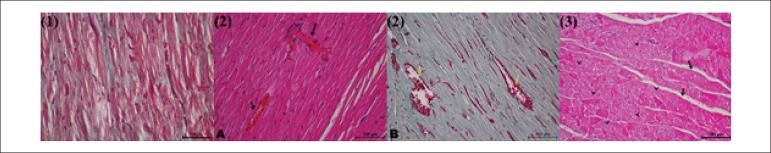
(1) Normal histological view of cardiac myofibrils in IPreC group.
(Longitudinal section, Masson Trichrome stain, Magnification: 40X).
(2) Congestion in IPreC+ MCAo (A) and STZ+ IPreC+ MCAo (B) groups.
Overview of myofibril is nearly normal appearance. (Longitudinal
section, A. H-E stain, B. Masson Trichrome stain, Magnification:
20X). (3) Eosinophilic stained areas show necrotic myofibrils that
are lack of nuclei (arrow-heads) in STZ group. Arrows indicate that
spaces between cardiac myofibrils. These spaces indicate necrotic
area, and probably interstitial edema. (STZ, Streptozotocin-induced
diabetic; IPreC, ischemic preconditioning; MCAo, middle cerebral
artery occlusion, Transverse section, H-E stain, Magnification:
20X).